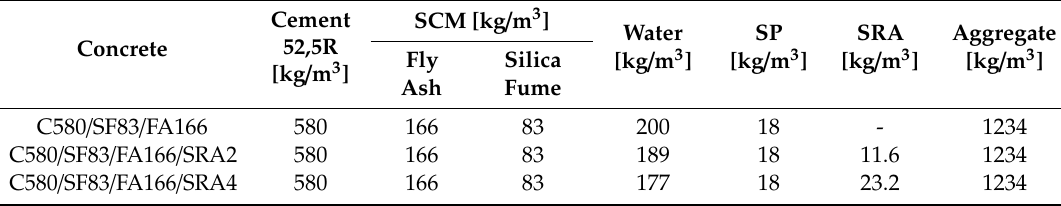
Table 1. Composition and notification of concrete